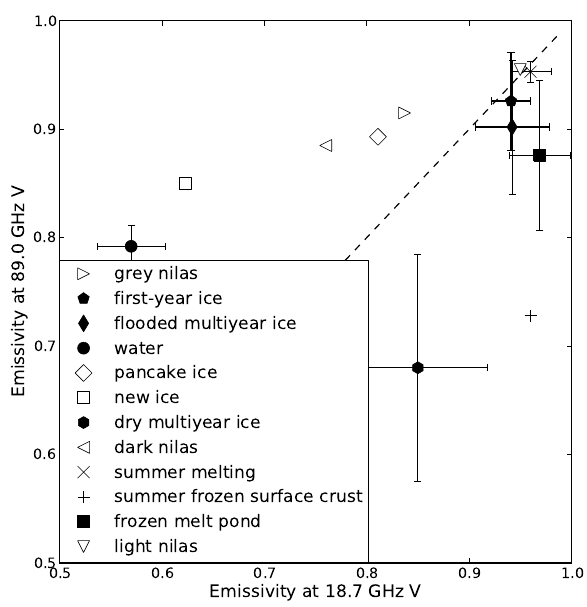
Fig. 1. Emissivities of different sea ice classes in a comparison of the vertical polarized frequencies 18.7GHz and 89.0GHz. Thin ice classes are plotted with contoured markers, other ice classes and open water with solid markers. The dashed line shows an emissivity ratio of r (cid:15) = 1. The values are taken from Eppler et al. (1992). The error bars display standard deviations if